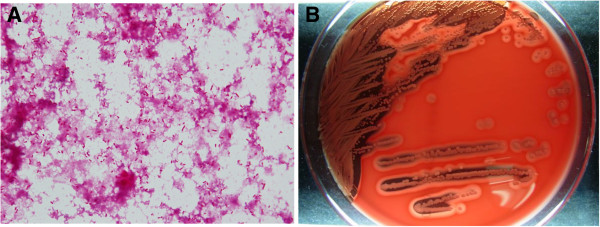
Microbiological results. A. A large number of short, tapered, gram-negative bacilli were present in fasciotomy. (Gram stain, ×400 original magnification). B. Chromobacterium haemolyticum colonies, showing marked hemolysis on sheep blood agar after a 24-h culture.